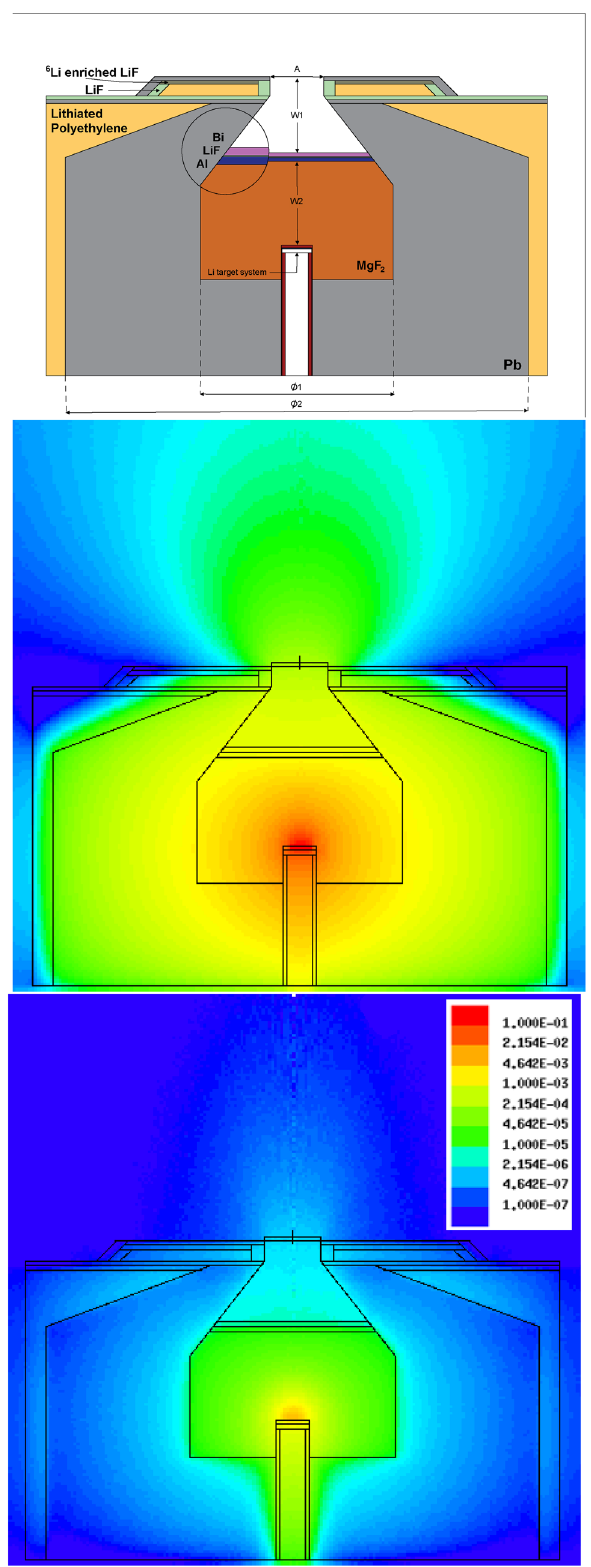
Figure 3. Upper panel : Layout of the BSA design, including general sizes and material specification. Middle and lower panel : Neutron and gamma radiation flux distribution throughout the BSA. The color key illustrates the neutron and photon intensity relative to the total neutrons generated in the